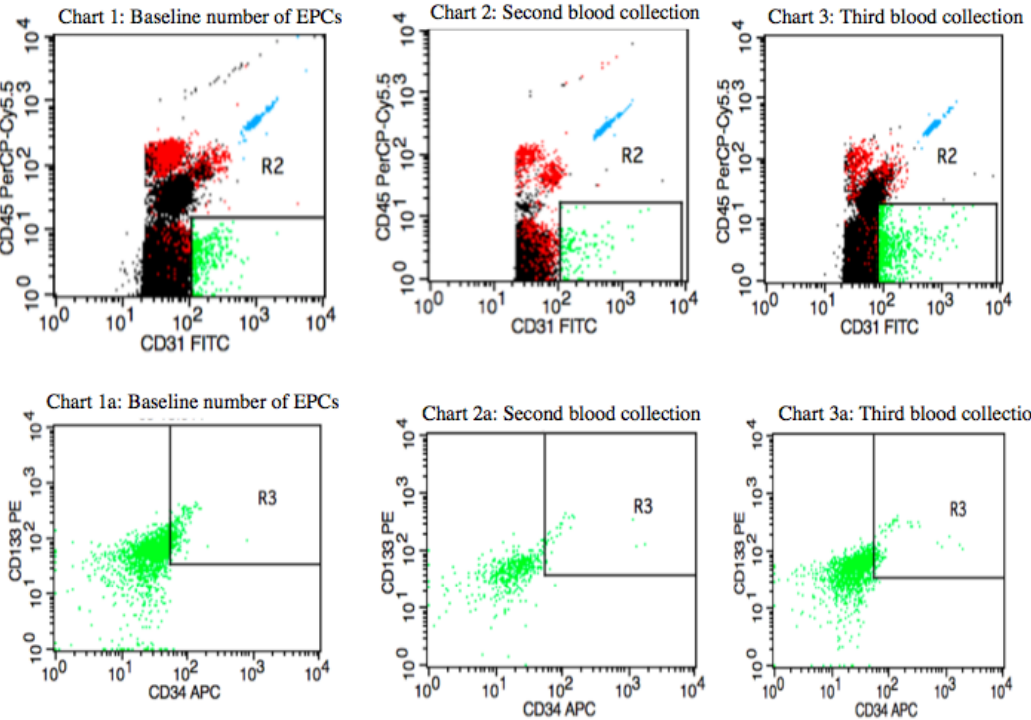
Figure 2. Quantification of circulating EPCs in blood mononuclear cells from invasive breast cancer patient with high pre-treatment level of circulating EPCs with a clinical profile: T1c, N1, M0, grade = 3, tumour diameter was 1.8 cm, ER/PR-HER2-Ki-67 = 10%. A baseline number of circulating EPCs was 22.6 cells/µL (first blood collection); during a second blood collection, the number of circulating EPCs dropped to 3.52 cells/µL; during a third blood collection, the number of circulating EPCs increased to a level of 10.05 cells/µL. The patient, after 40 months of follow-up, is still alive.